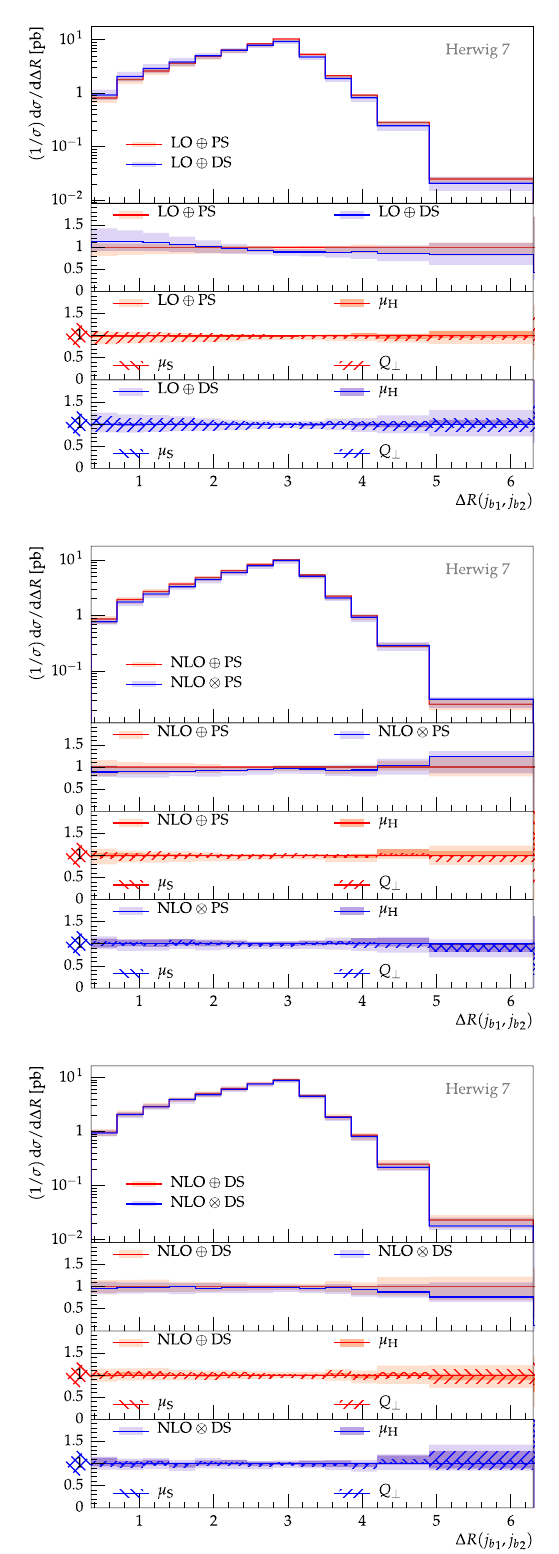
( Δφ 2 + Δη 2 distribution, described in Fig. 17 The Δ R ( b 1 , b 2 ) = the text, simulated for semileptonic 8 TeV pp → t ¯ t